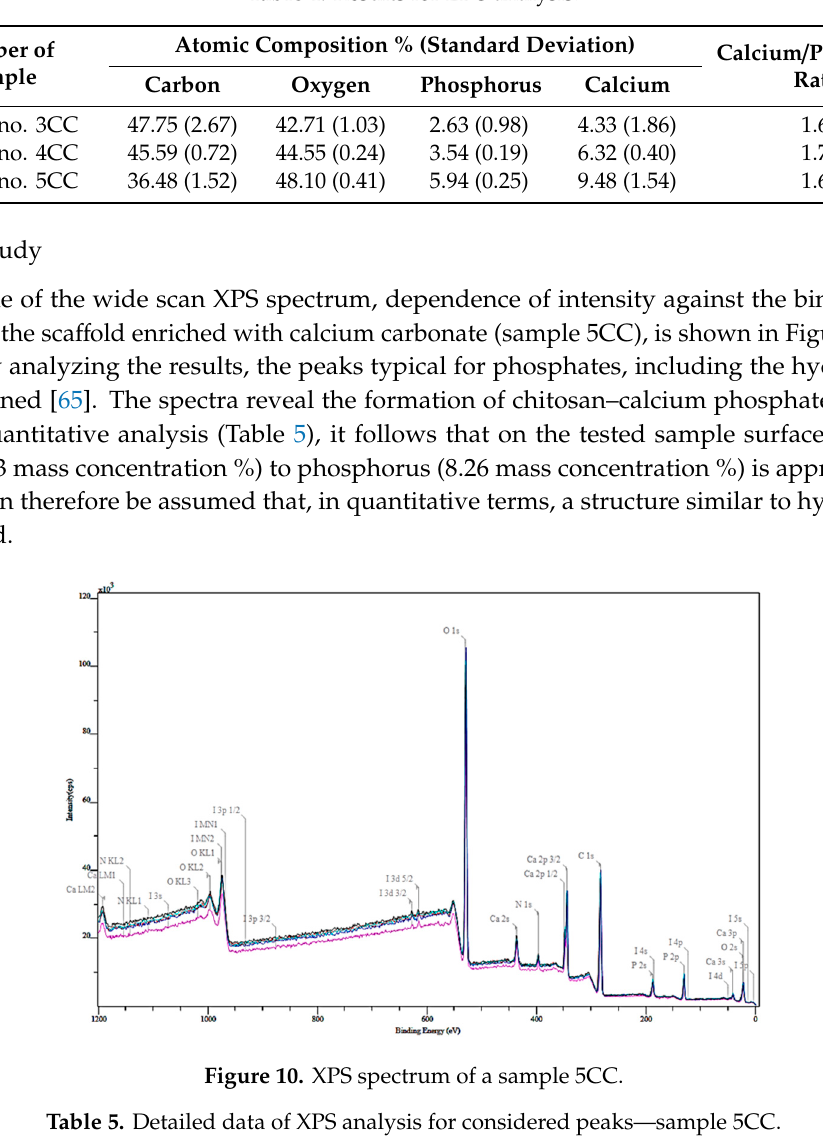
Table 4. Results for EDS analysis.